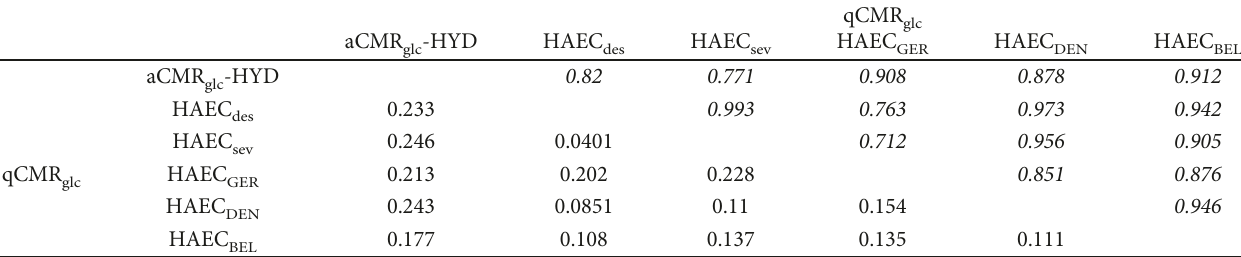
Table 2: Results of quanti fi ed CMR (qCMR ) from Figure 1(a), where HAEC groups from di ff erent sites are compared to absolute CMR glc glc from Hyder et al. [36] (aCMR -HYD). The upper triangular half is Pearson correlation (italicized), whereas the lower triangular half is glc Euclidean distance (non-italicized). In the table p = 0 for all entries. The Pearson correlations were highly signi fi cant, and all the Euclidean distances were less than even one despite a total of 41 dimensions ’ means. The high similarity between qCMR measured at di ff erent sites indicates that comparisons between sites are possible using our procedure for quanti fi ed CMR